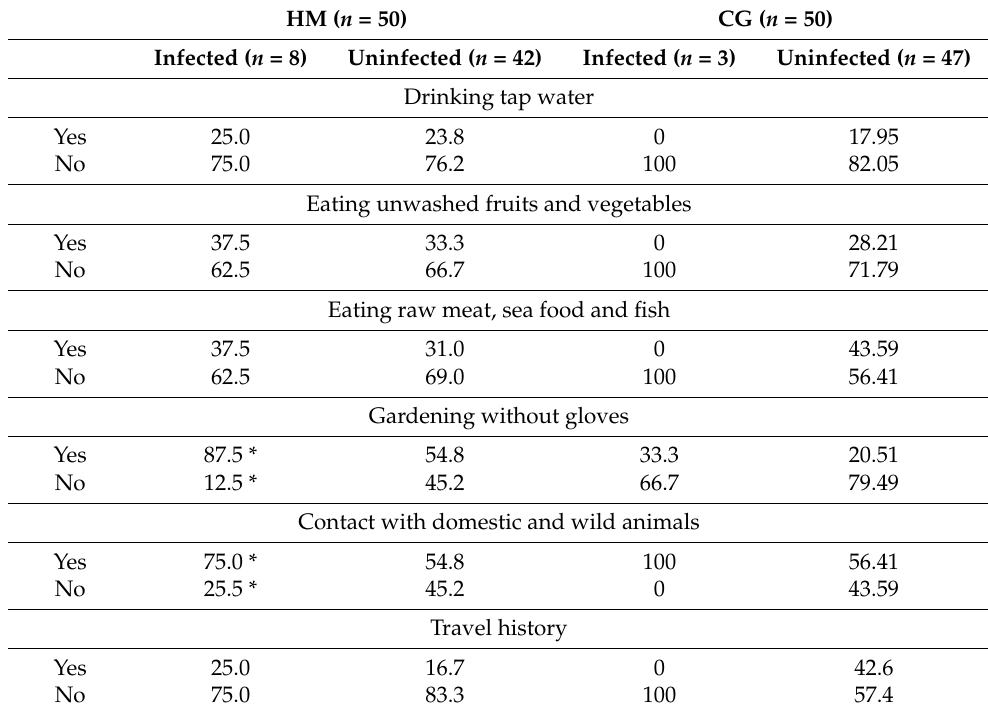
Table 2. The prevalence of intestinal parasites (%) in the HM and CG groups according to environ- mental risk factors. HM ( n = 50) CG ( n =